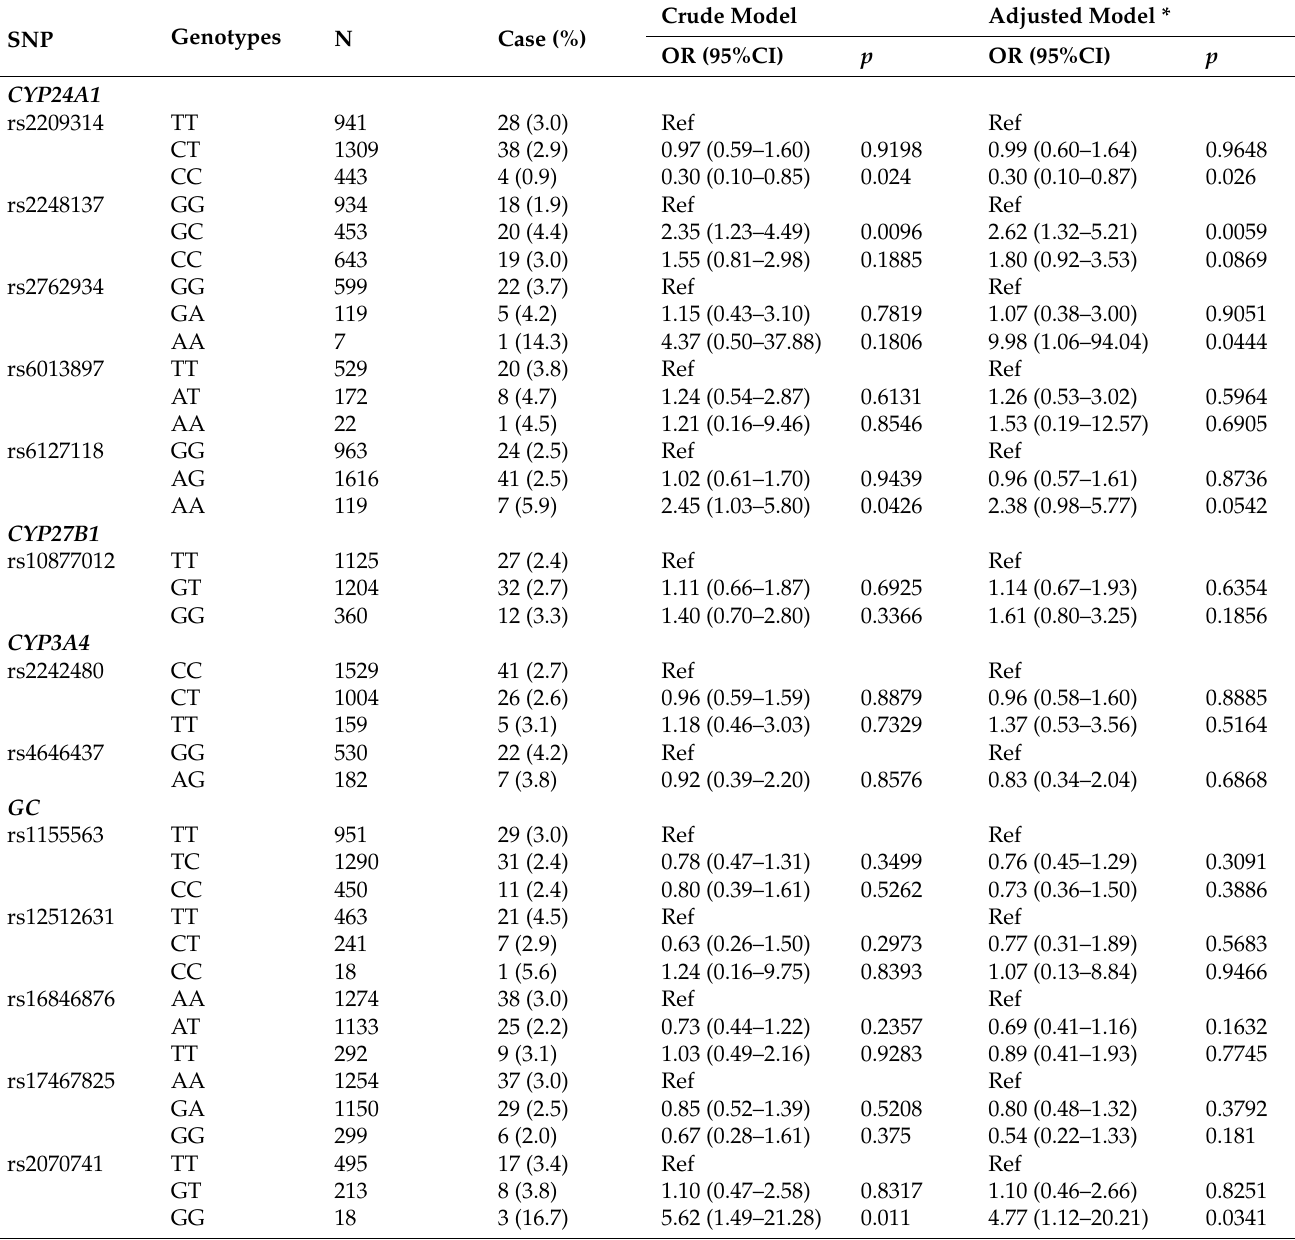
Table 5. The relationship between single SNP and HDP